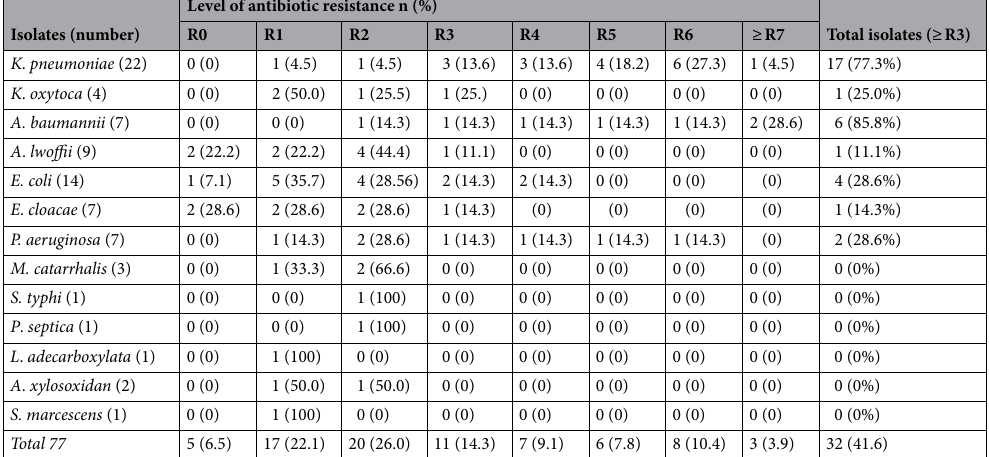
Table 5. The multi-drug resistance level of blood-born Gram-negative bacteria. R0 resistance to no antibiotics, R1 resistance to one antimicrobial category, R2 resistance to two antimicrobial categories, R3 resistance to three antimicrobial categories, R4 resistance to four antimicrobial categories, R5 resistance to five antimicrobial categories, R6 resistance to six antimicrobial categories, resistance ≥ 7 resistance to seven antimicrobial categories, ≥ R3 nonsusceptibility to at least one agent in 3 or more classes of